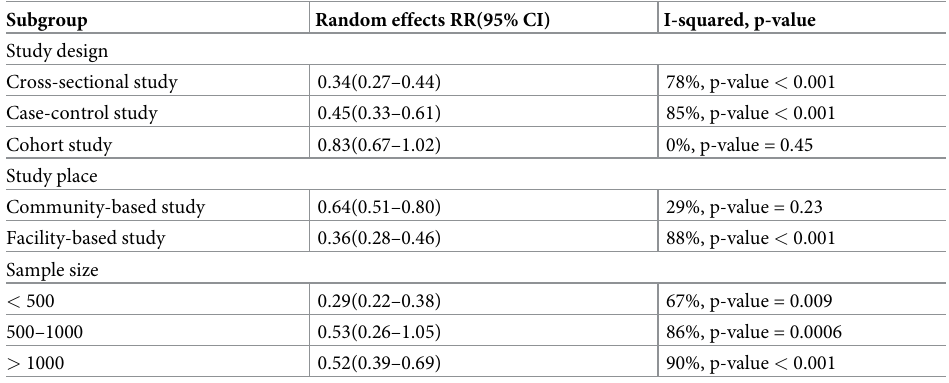
Table 3. Studies’ subgroup analysis modifying the effect of ANC on perinatal outcomes in